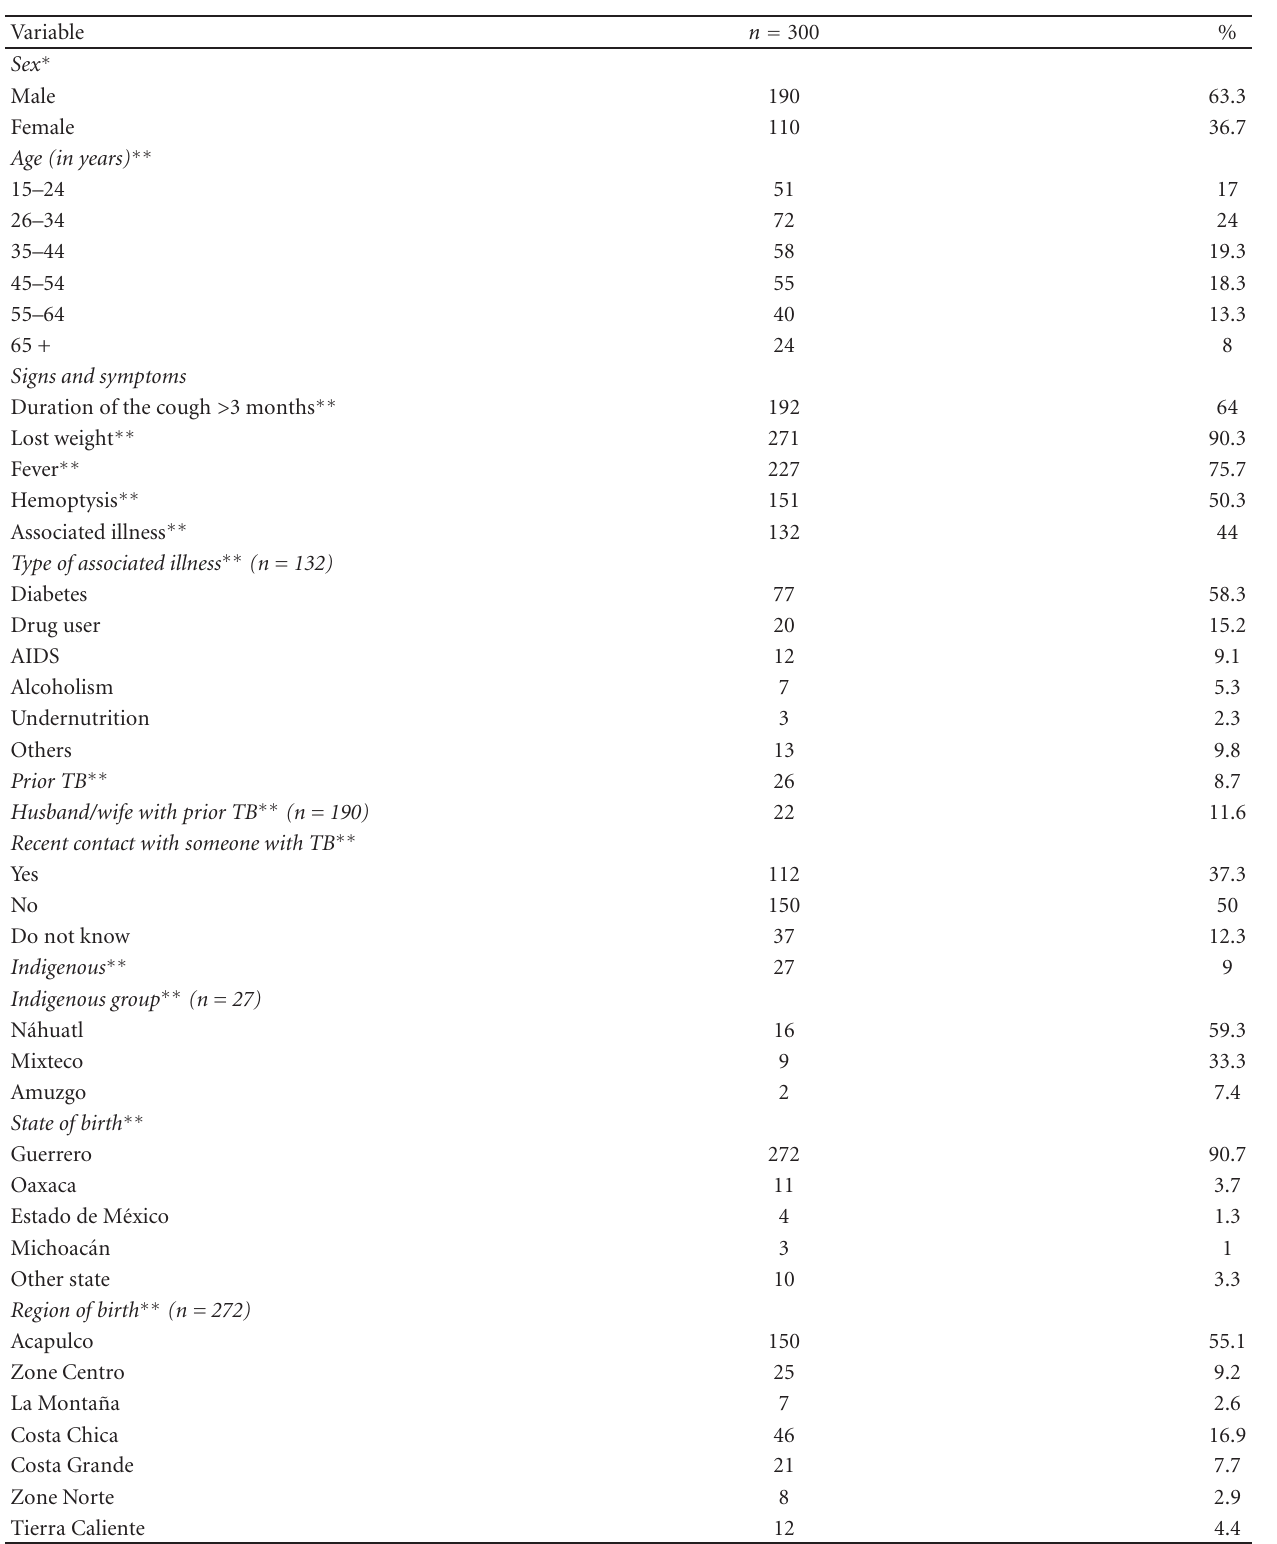
Table 3: Characteristics of the pulmonary TB case series in